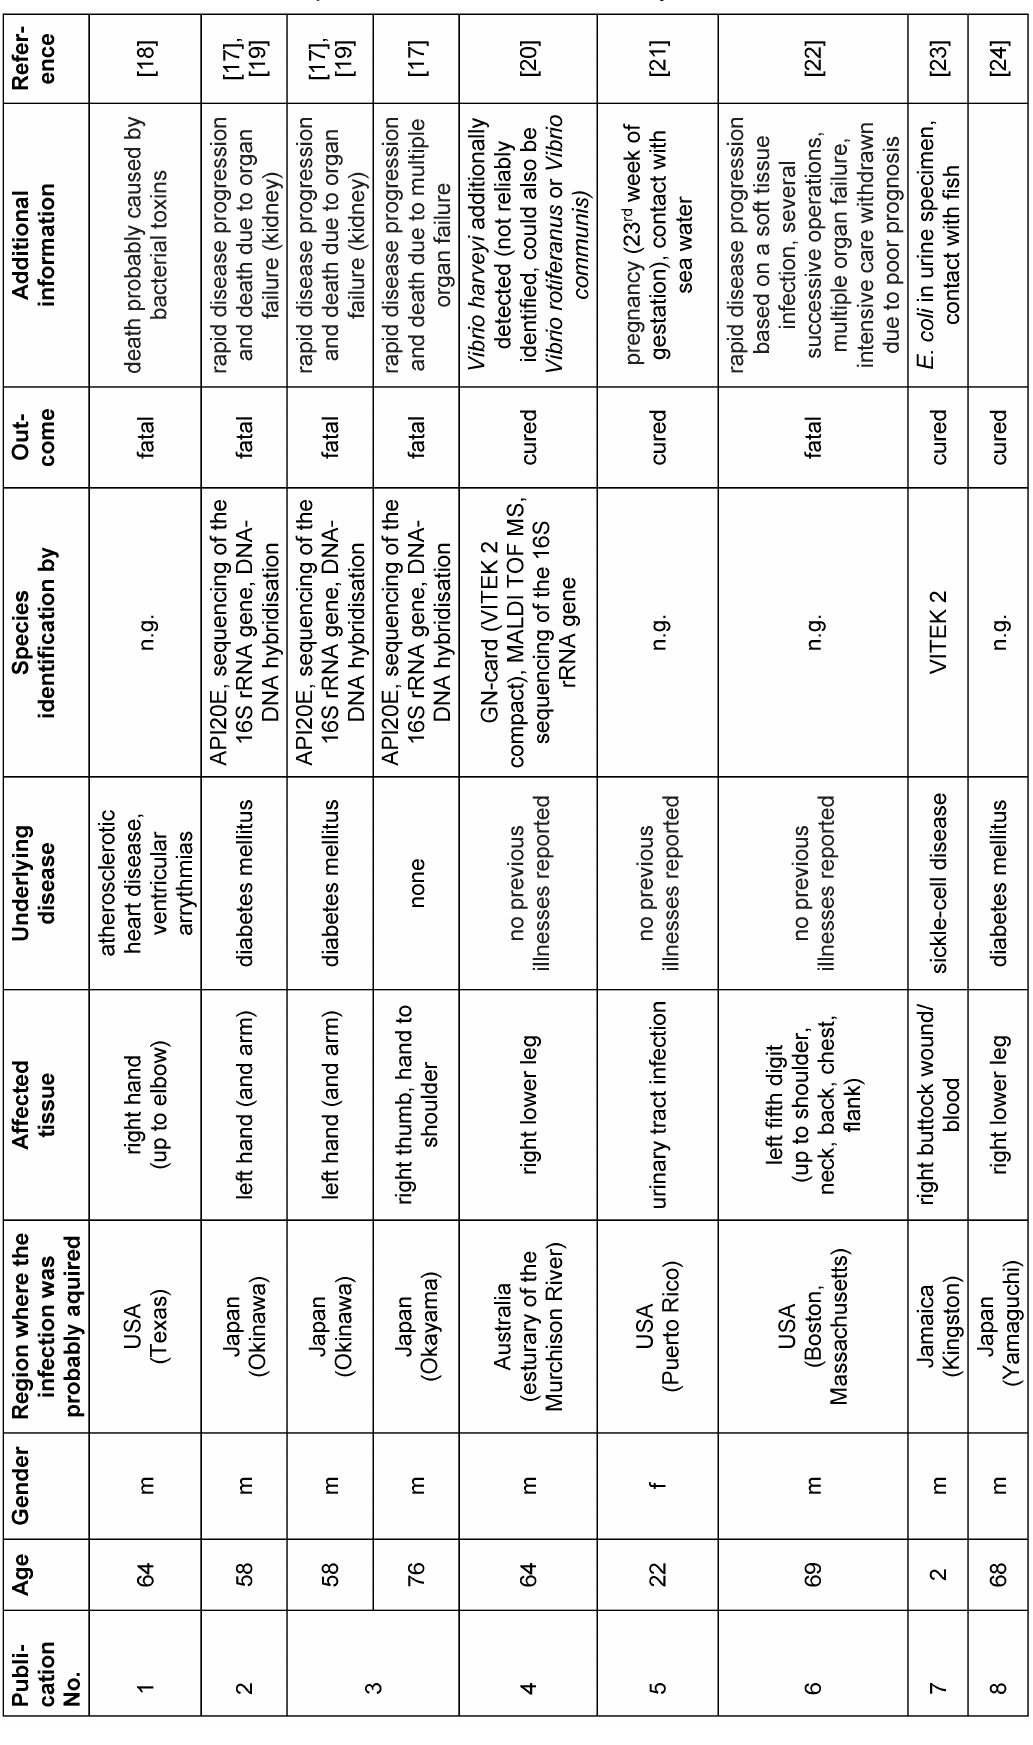
Table 1: Overview of reports on human infections caused by